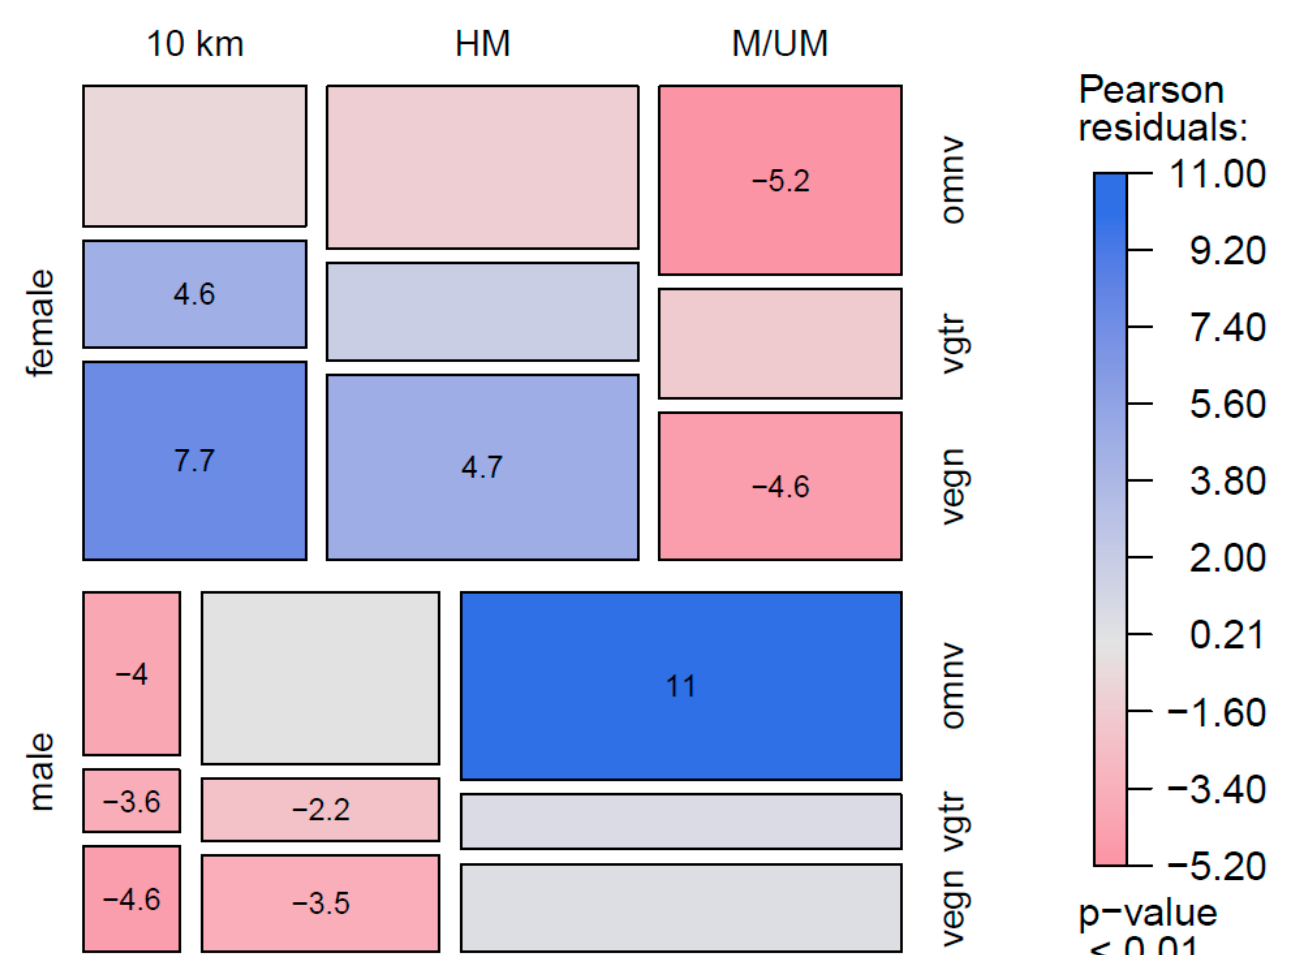
Figure 2. Association between Sex, Race Distance and Dietary Subgroups of Endurance runners. Note: Exceptionally (significantly) high values are visualized with blue and strikingly (significantly) low values are visualized with red. <21 km—less than half-marathon; HM—half-marathon; M/UM—marathon/ultra-marathon. Vegn—vegans: avoid all foods and ingredients from animal sources; vgtr—vegetarians: avoid all flesh foods but consume egg and/or dairy products; omnv—omnivores: have no restriction on source of